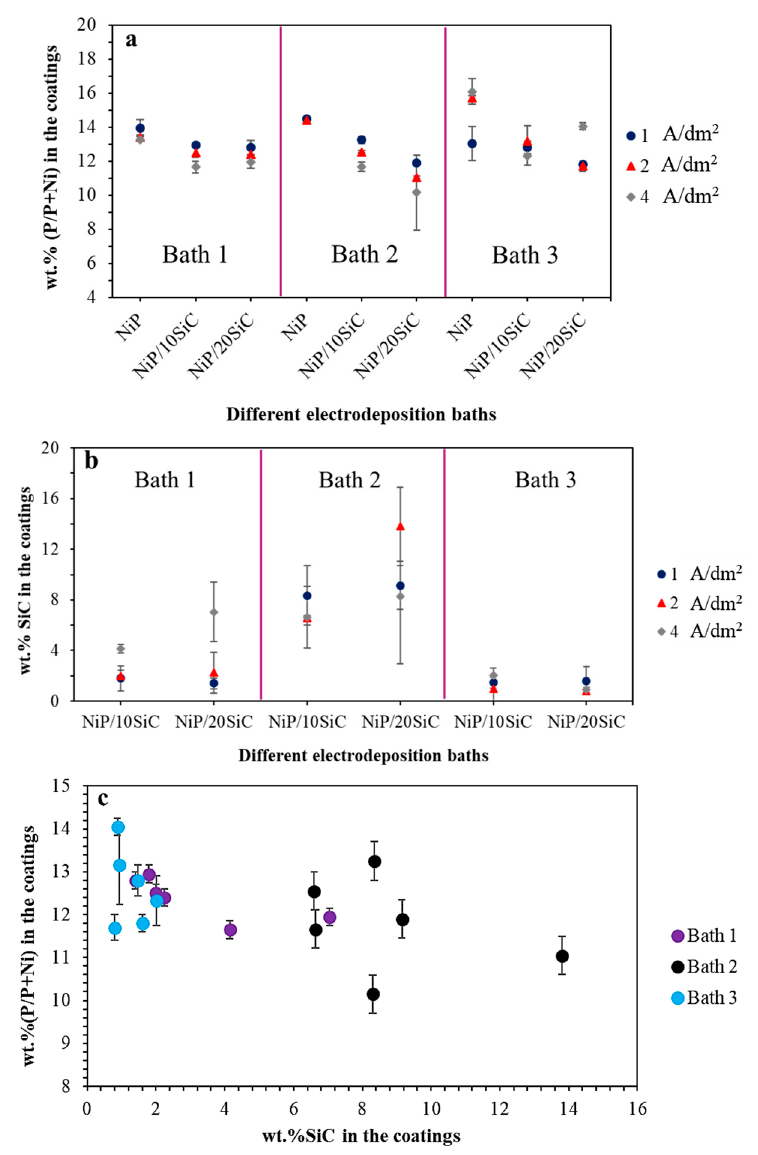
Figure 6. The composition of NiP and composite coatings deposited at different conditions ( a ) wt.% P in the metallic coating, ( b ) wt.% SiC ( c ) The relation between wt.% P and wt.% SiC in the coatings.